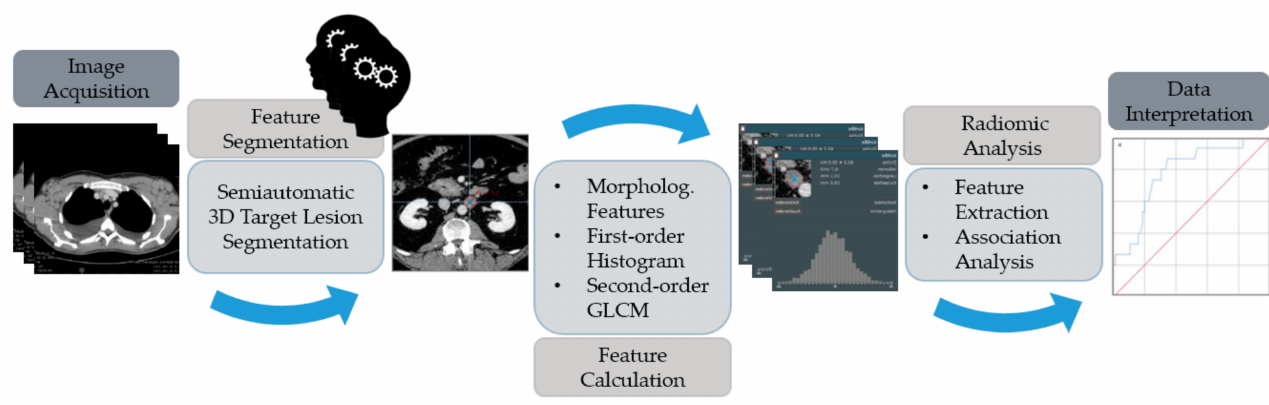
Figure 2. The schematic diagram for data processing and analysis. Size measurements, including 3D volume, were obtained as were first and second order textural features. Equations for these textural features can be accessed at https://pyradiomics.readthedocs.io/en/latest/features.html (accessed on 7 October 2021). Detailed settings of the extraction are listed in Appendix A, Table